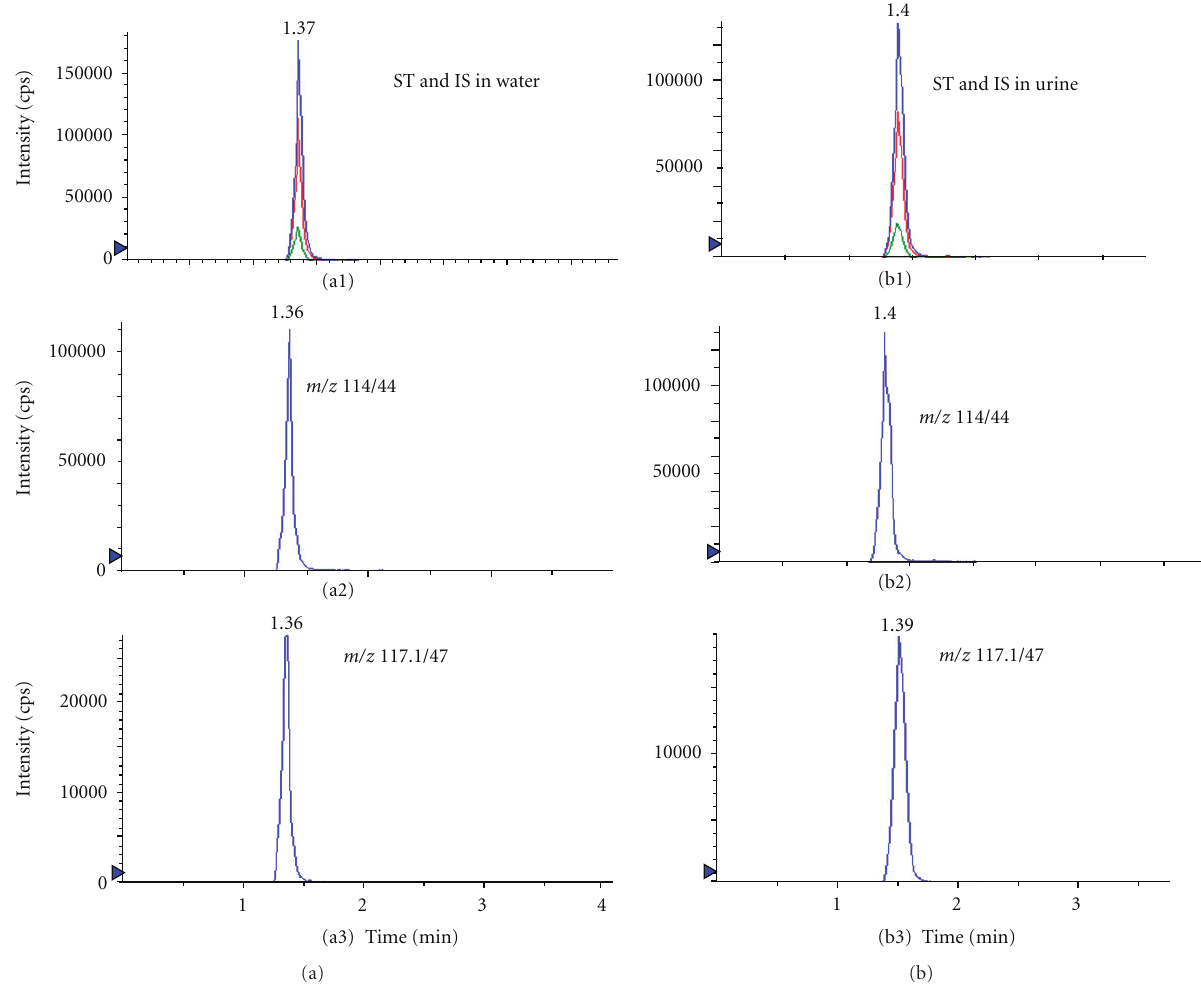
Figure 2: (a) Chromatograms of creatinine standard and creatinine-d 3 , disolved in water (total ion (top), creatinine standard (middle), and creatinine-d 3 (bottom)). (b) Chromatograms of creatinine and creatinine-d 3 in 2000-fold diluted urine samples (total ion (top), creatinine standard (middle), and creatinine-d 3